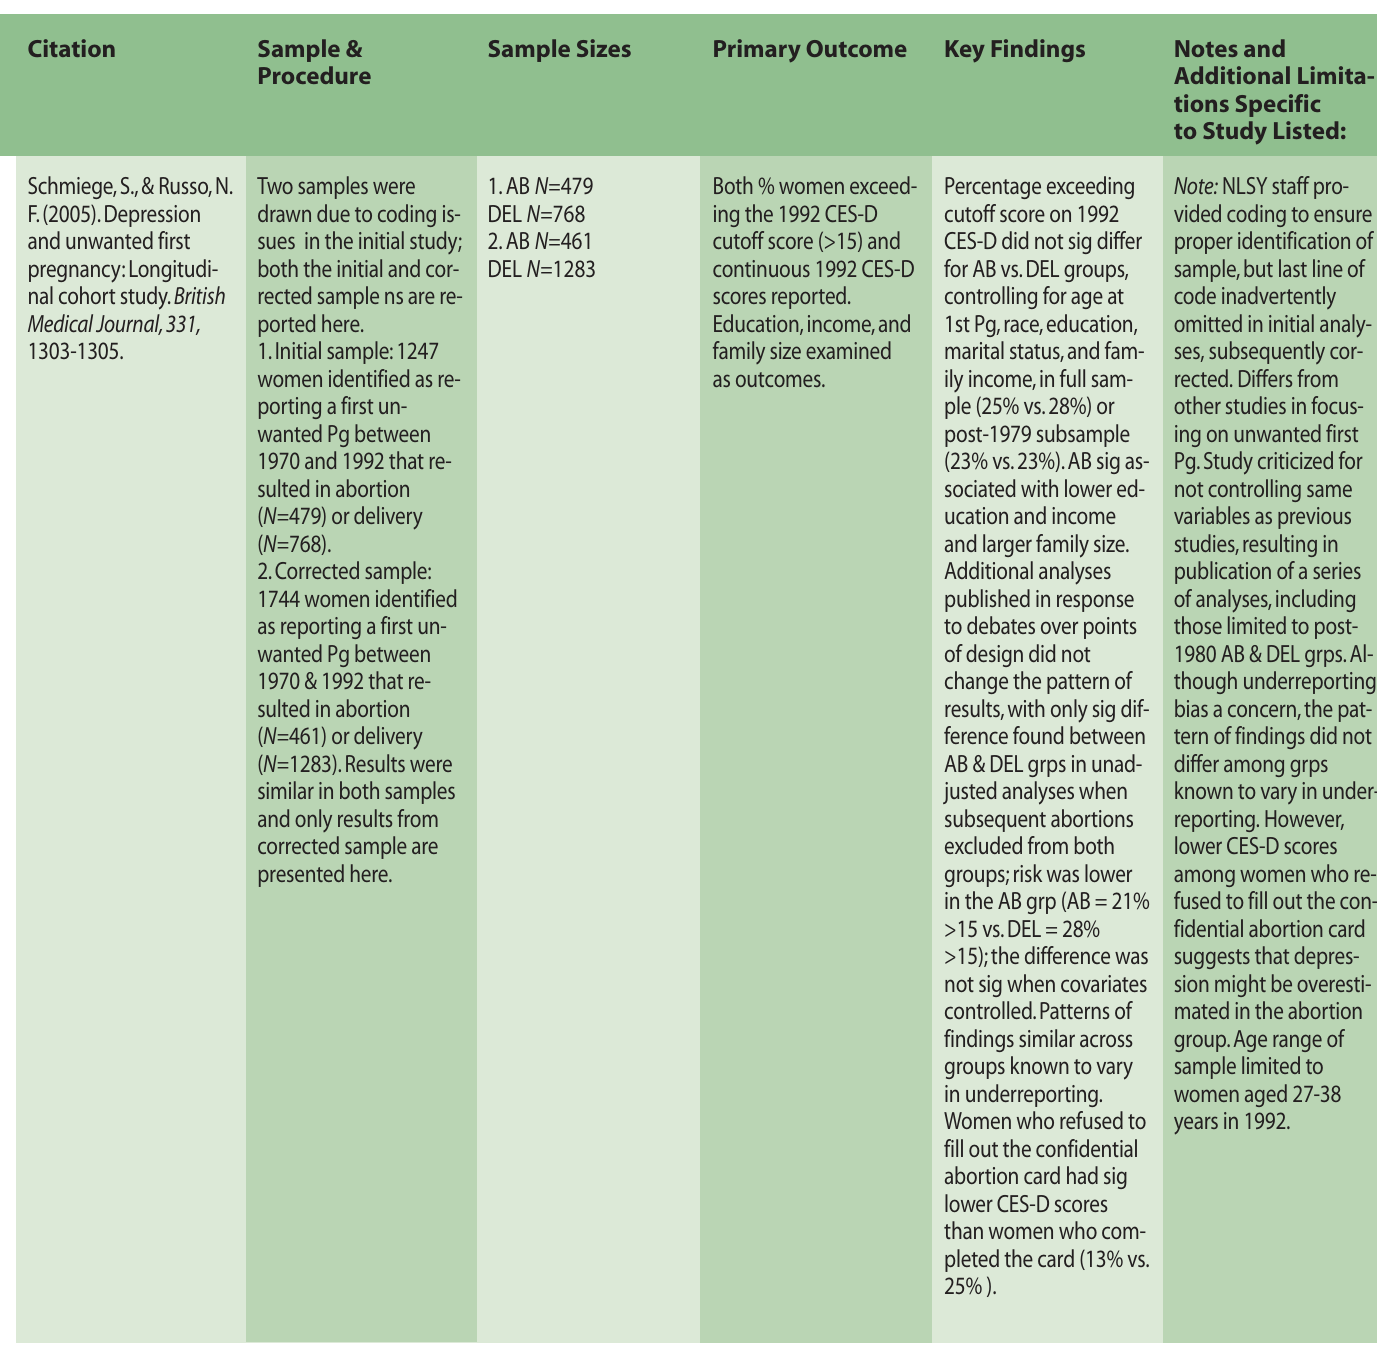
Table 2: Secondary Analyses of Survey Data–Abortion vs.Comparison